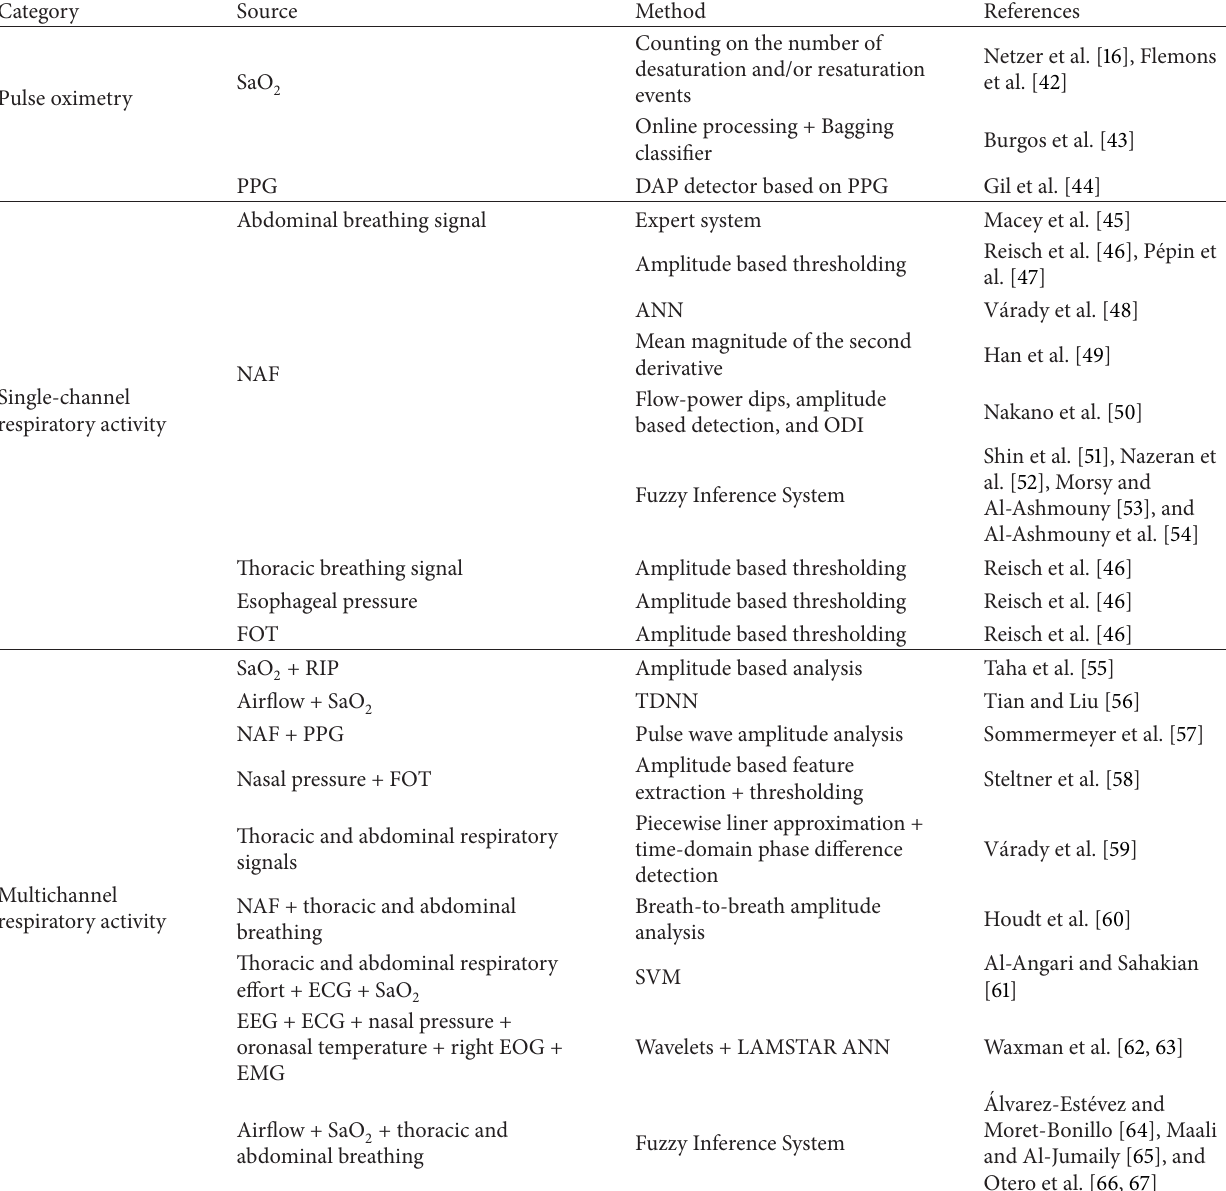
Table 3: Summary of apneic event detection